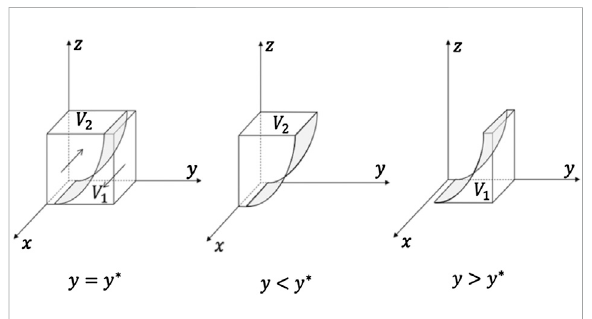
FIGURE 5 Phase diagram of government strategy evolution.